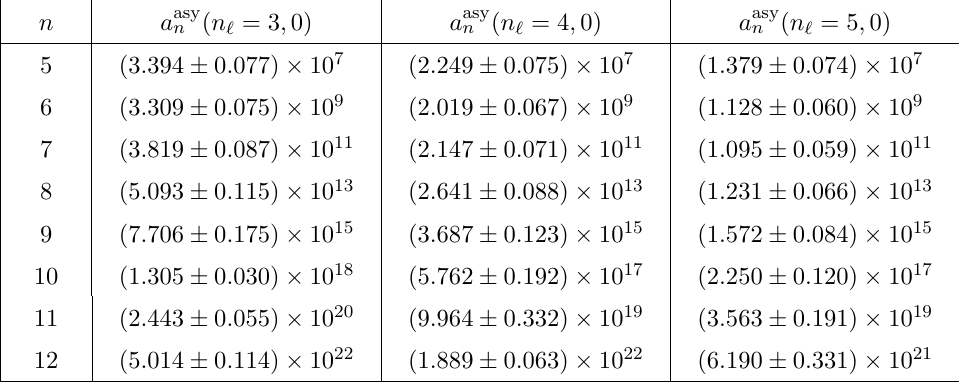
Table 2 . Coe(cid:14)cients of the pole-MSR mass series for a n> 4 ( n ‘ ; 0) for n ‘ = 3 ; 4 ; 5 estimated from the asymptotic formula of eq. (2.26) and with uncertainties from eq. (2.21). coe(cid:14)cients. The results up to n = 12 for n eq. (2.21) are displayed in table